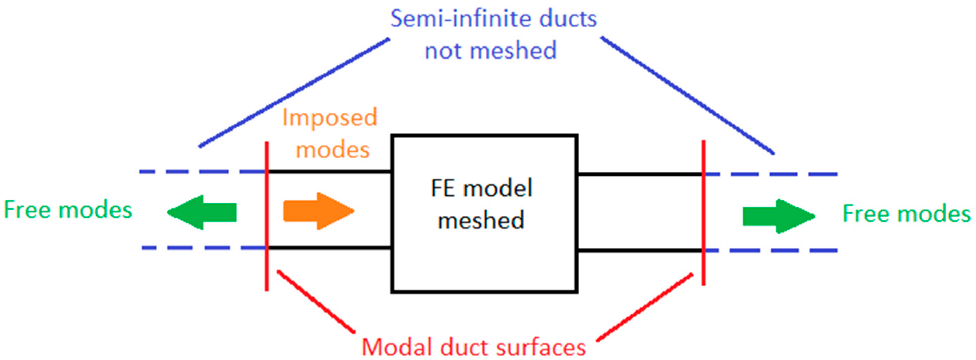
Figure 5. Schematization of the acoustic FEM model with duct modes.